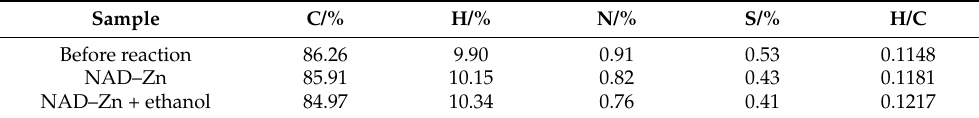
Table 2. Elemental content before and after aquathermolysis.